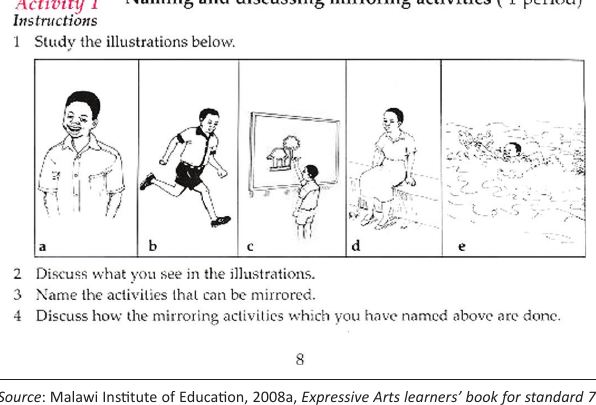
FIGURE 1: Teacher’s complaint about the instructional materials is also confirmed by the section from the grade 7